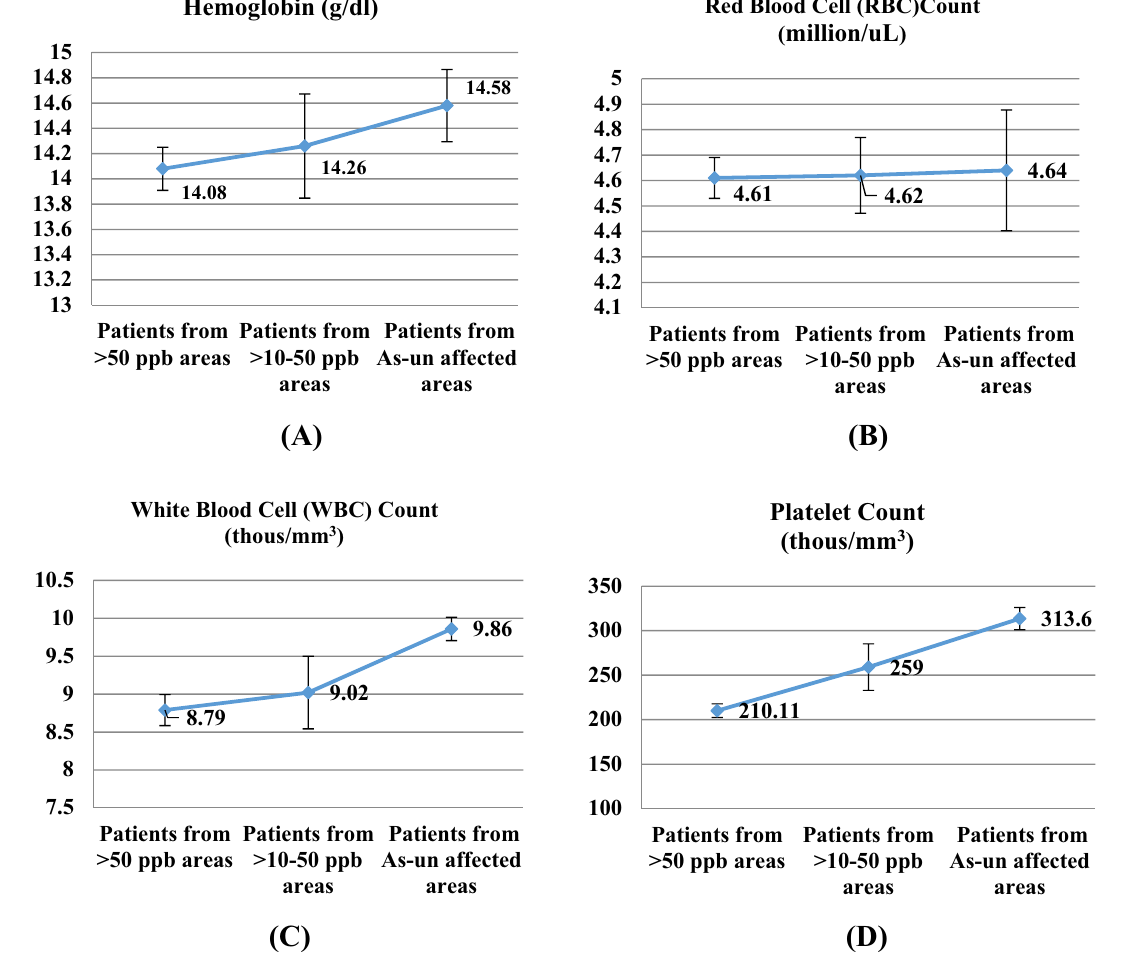
Figure 2. Levels of different biochemical parameters ( A ) hemoglobin, ( B ) red blood cell count, ( C ) white blood cell count and ( D ) platelet count in different patient categories. A decrease was seen in the patients exposed to higher concentrations of iAs (> 50